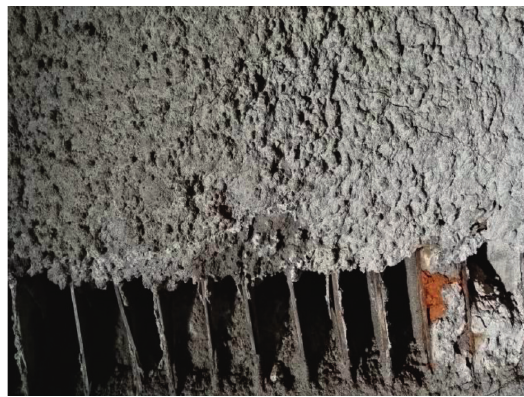
Figure 18: Primary support cracking (scheme